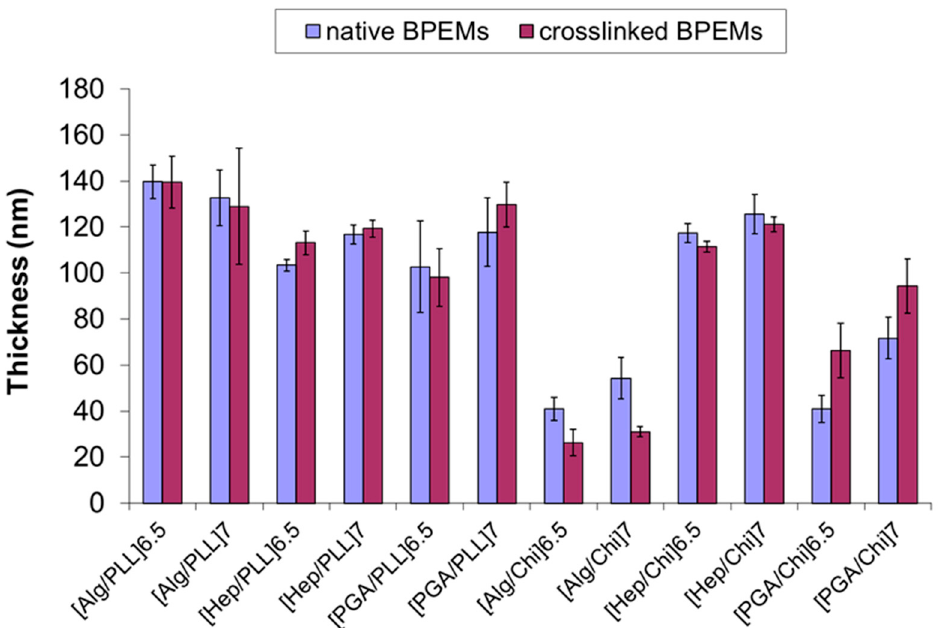
Figure 3. Nanofilm thickness before and after crosslinking of BioPEMs measured by ellipsometry. Error bars represent 95% confidence intervals (n = 15).